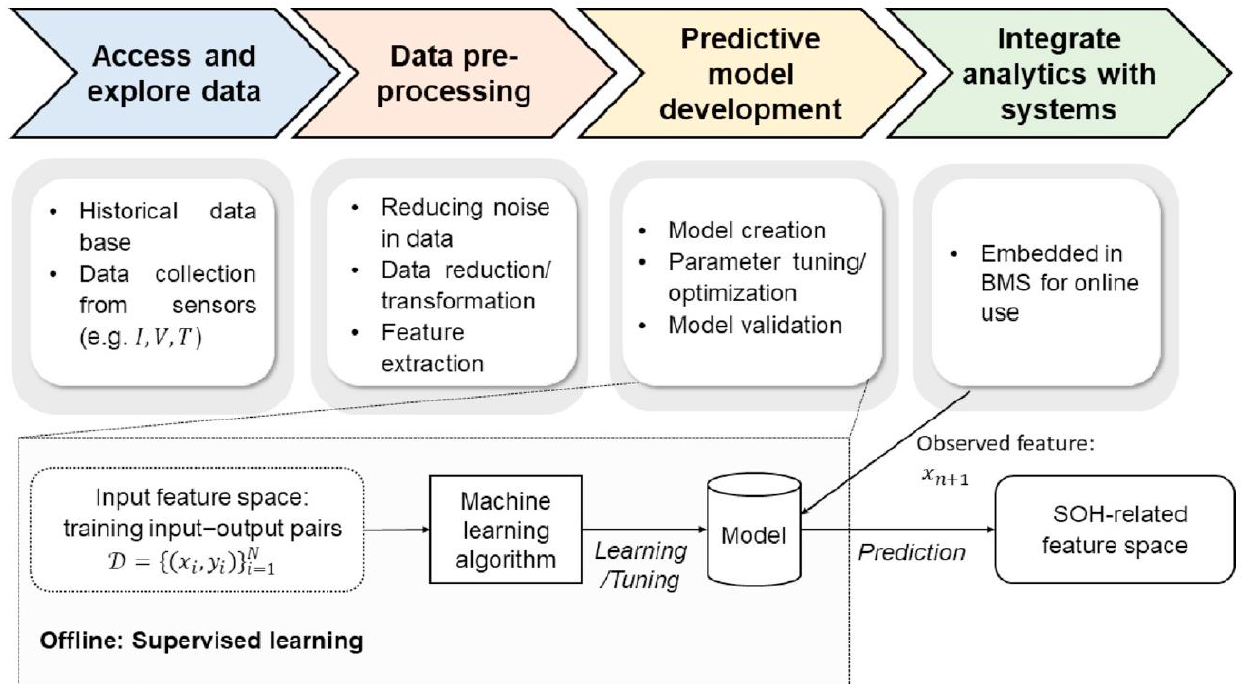
Figure 6. Generic workflow for data-driven SOH estimation methods [59]. Reprinted with permission from Ref. [59]. 2019, Elsevier.